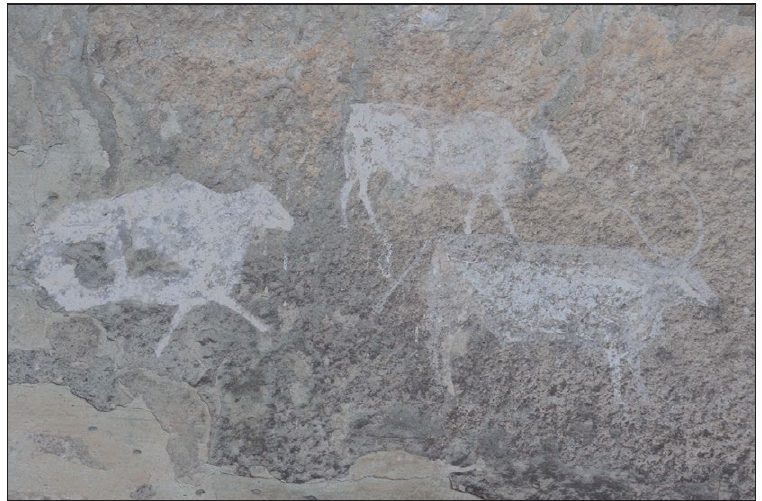
Figure 2: Paintings of cattle at the nearby FRE4 painted site. Five human figures painted in this shelter have been directly dated to 1297–present cal. BP (Bonneau et al. 2017a). Repro- duced with